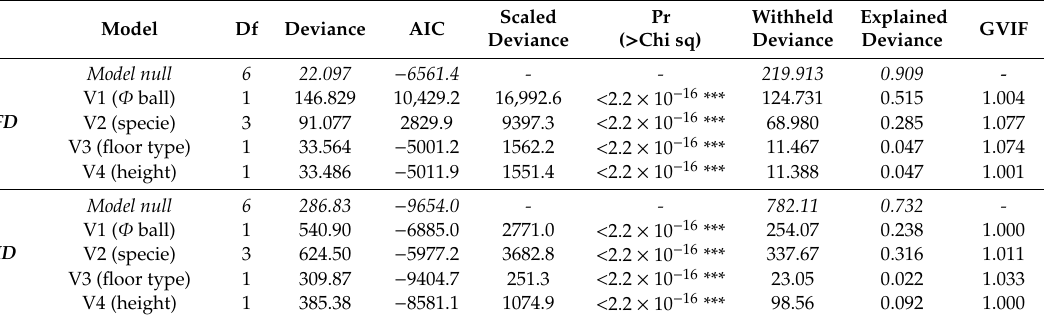
Table 11. Analysis of Deviance and Variance Inflation Factor.